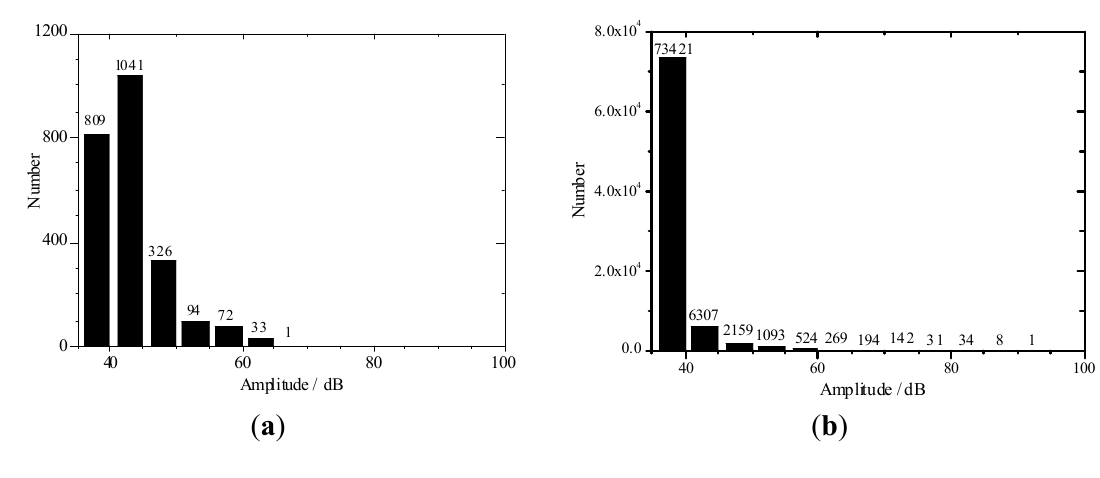
Figure 8. AE amplitude statistical distributions for PVA fiber contents concrete with: ( a ) 1.5 kg/m 3 , ( b ) 1.0 kg/m 3 and ( c ) 0.5 kg/m 3